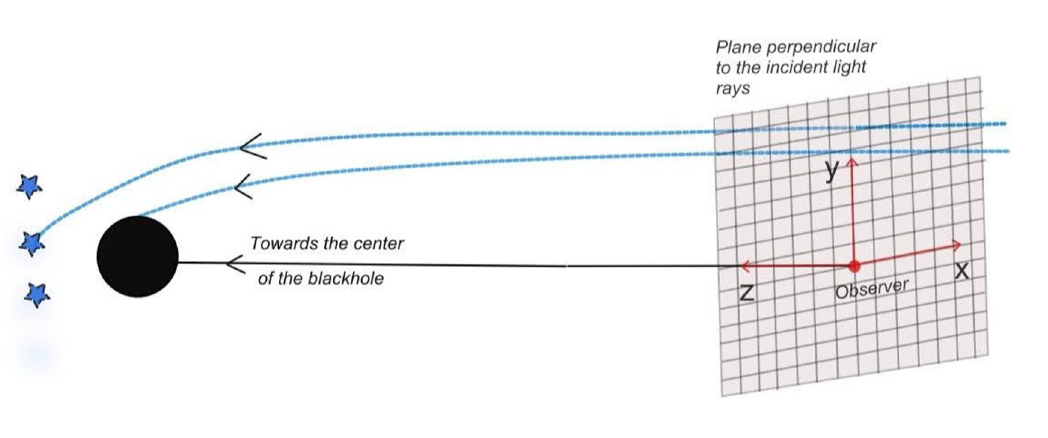
Figure 4 . Construction of the shadow of a black hole for a distant observer by tracing the light-rays, which arrive each pixel on the observer’s image plane, backward in time. The ( x, y, z ) is the observer’s local coordinate frame whose origin is given by ( r O , θ O , φ O ) in the black hole’s reference frame. The pixel’s position w.r.t. black hole frame in terms of its position w.r.t. local ( x, y, z ) frame is